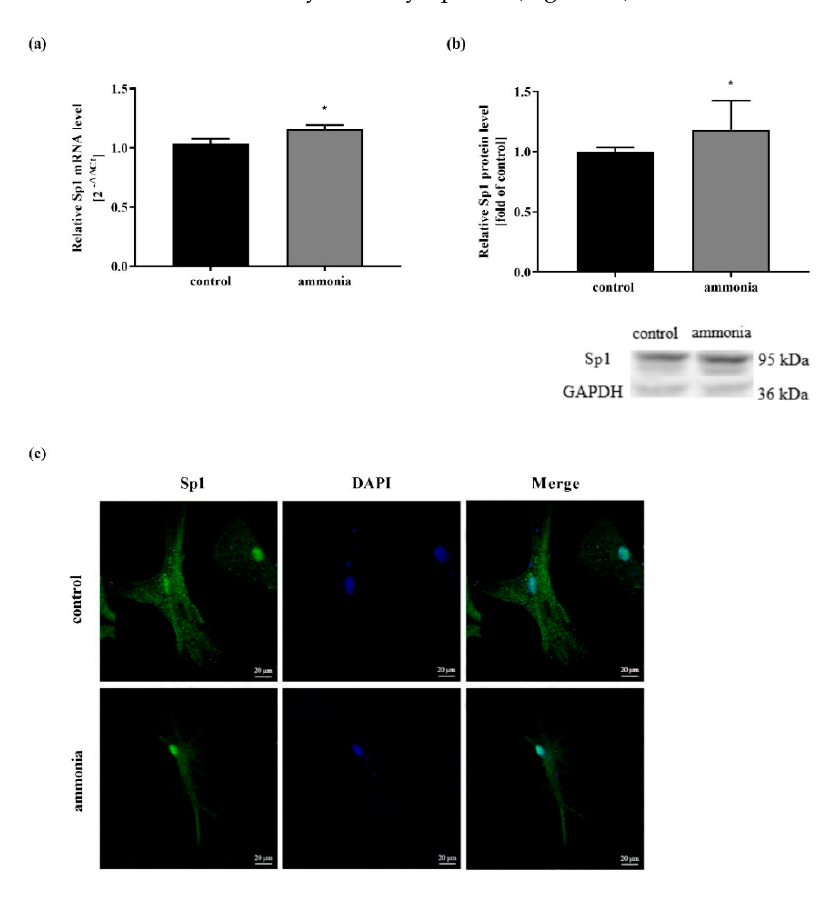
Figure 1. The effect of ammonia treatment on Sp1 expression and cellular localization. ( a ) Sp1 mRNA level in mouse cortical astrocytes after 24-h 5 mM ammonia treatment. Results are mean ± SD ( n = 4). (*) p < 0.05 vs. control; Student t-test. ( b ) Sp1 protein level in mouse cortical astrocytes after 24-h 5 mM ammonia treatment. Upper panel shows densitometry analysis, lower panel shows representative immunoblot. Results are mean ± SD ( n = 4). ( c ) Intracellular Sp1 transcription factor localization after 24-h 5 mM ammonia treatment ( n = 4).